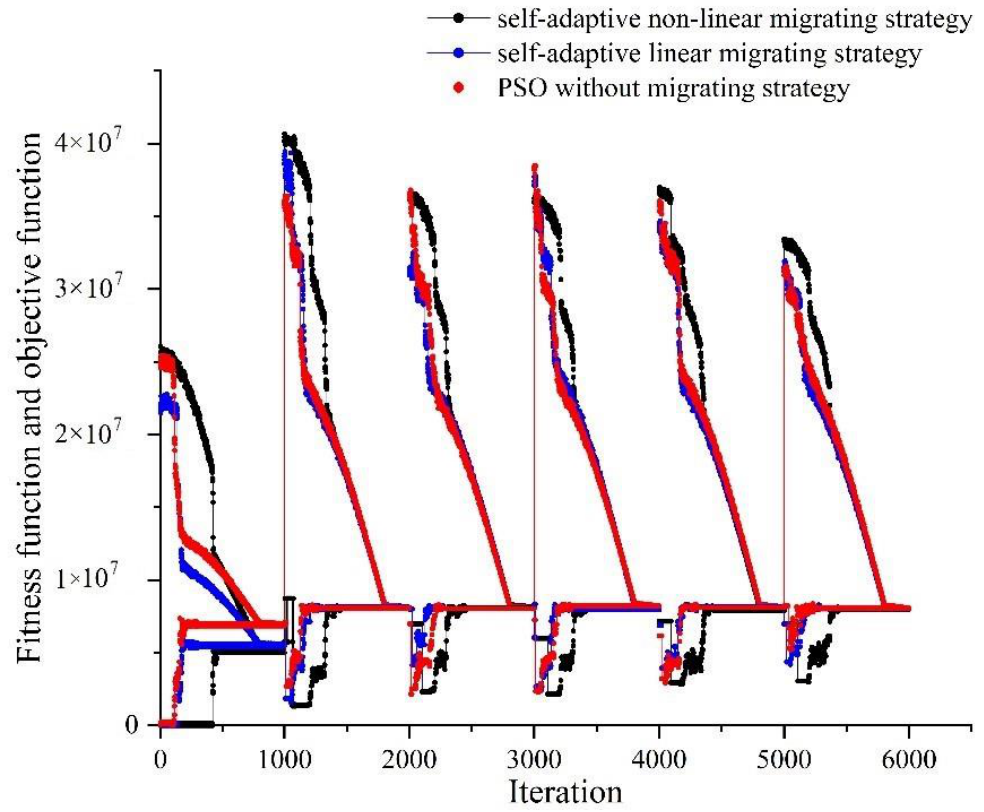
Figure 9. Convergence curve in the case of three migrating strategies.